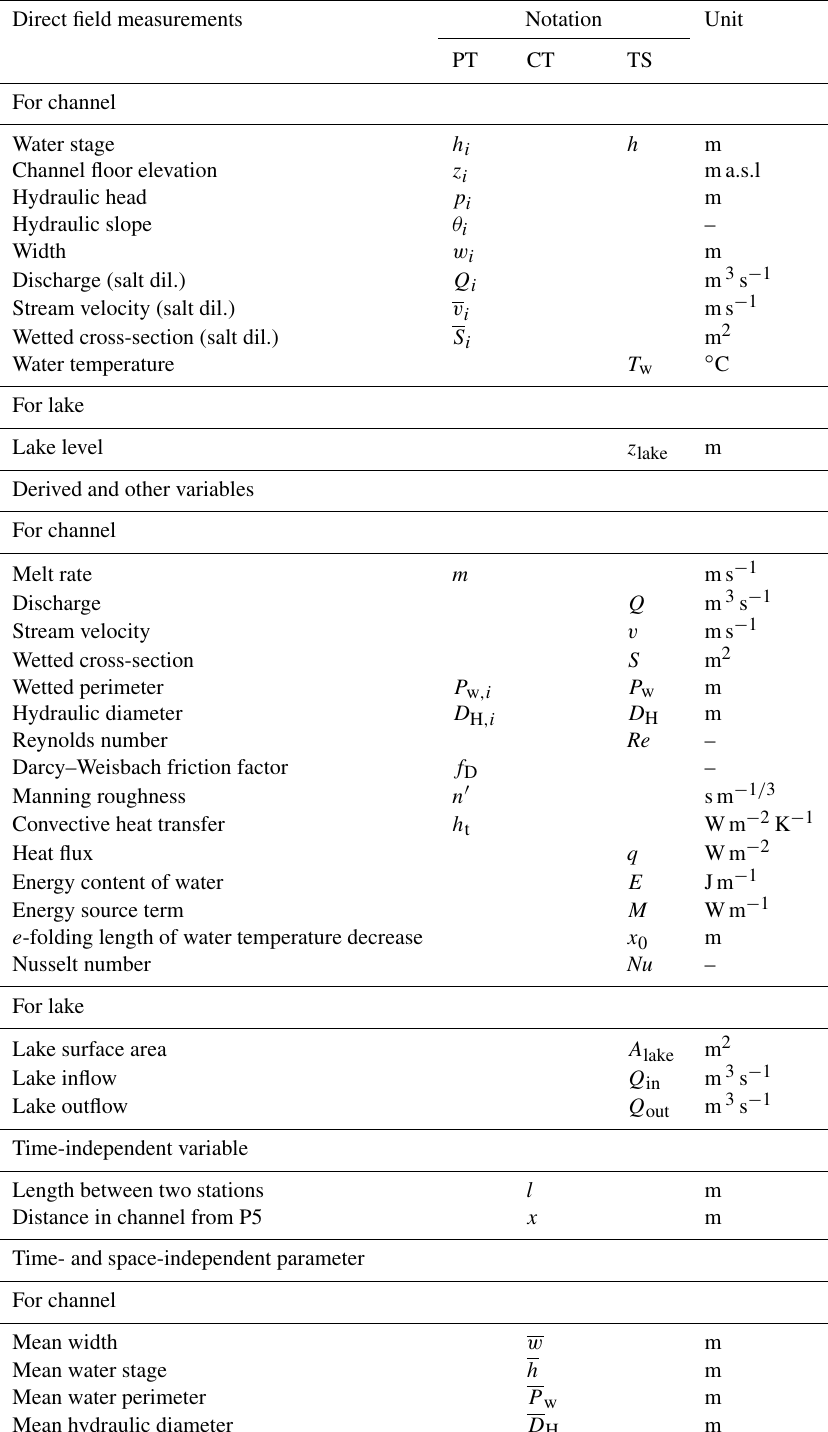
Table 2. Table of variable names. The term salt dil. stands for “salt dilution experiment technique”, and a.s.l stands for “above sea level”. Individual quantities might be available either for a point in time (PT; the index (i) means that the measurement is instantaneous) or as a time series (TS), or they might be constant through time (CT). A bar over the corresponding symbol indicates that the quantity is averaged over a given channel segment, i.e. between two